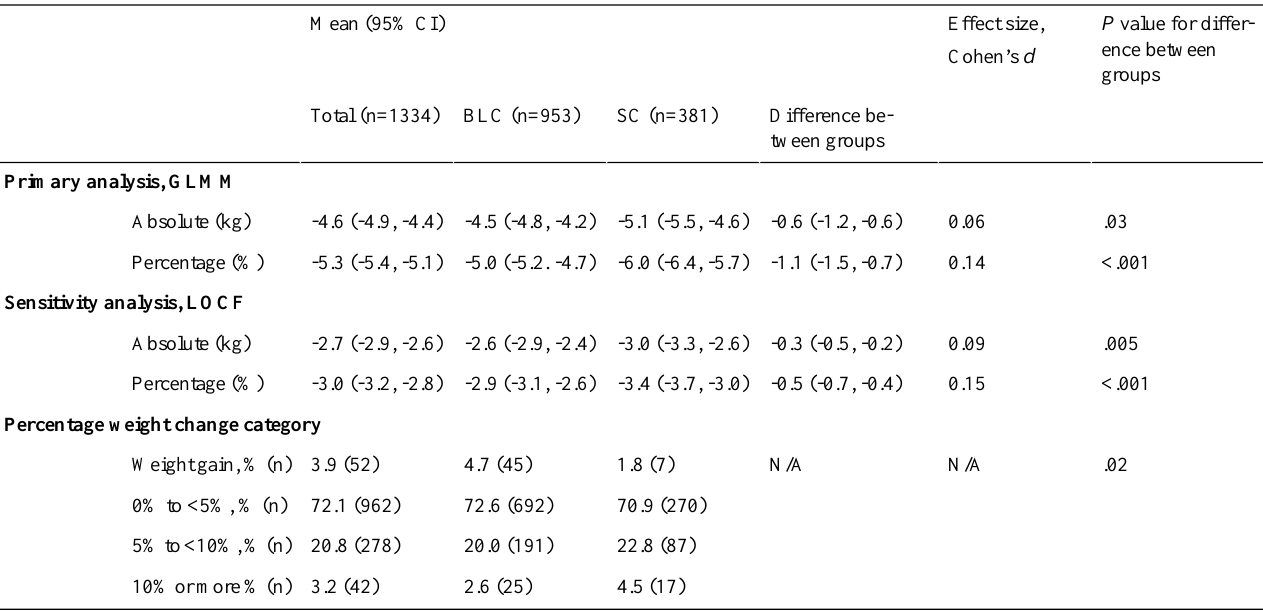
a Differences between programs tested using chi-square test for categorical data and t tests for continuous data. Table 3. Weight change after 8 weeks for BLC and SC participants using GLMM and LOCF (all analyses controlled for baseline age and